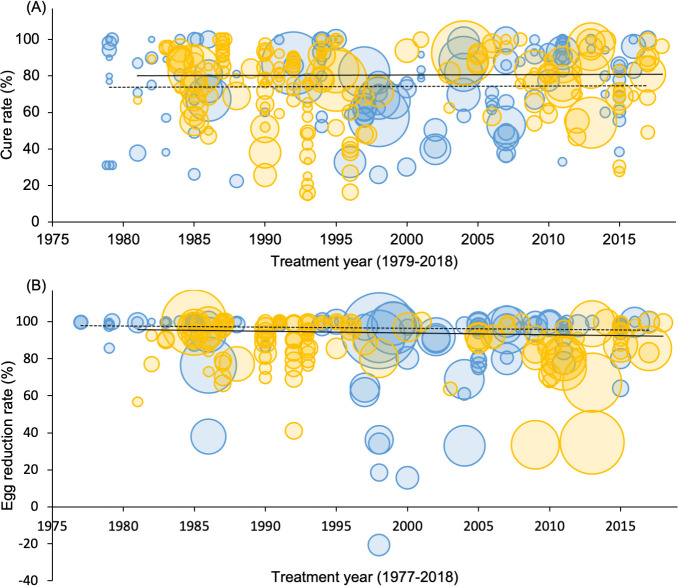
Scatter graphs of the reported cure rate (graph A) and egg reduction rate (graph B) by treatment year. Each plot represents the reported cure rate/egg reduction rage of S. haematobium in blue and S. mansoni in orange. The size of each plot represents the number of participants of each observation. Lines are fitted graphs generated from random-effects meta-regression models. Heavy lines denote the cure rate or egg reduction rate of S. mansoni infection. Dashed lines denote the cure rate and egg reduction rate of S. haematobium infection. For graph A: fitted lines denote the cure rate over the reported treatment years that could be achieved among children treated with 40 mg/kg bodyweight praziquantel and one parasitological sample used for a diagnostic. Similarly, for graph B, fitted lines denote the egg reduction rate with 40 mg/kg body weight praziquantel treatment.